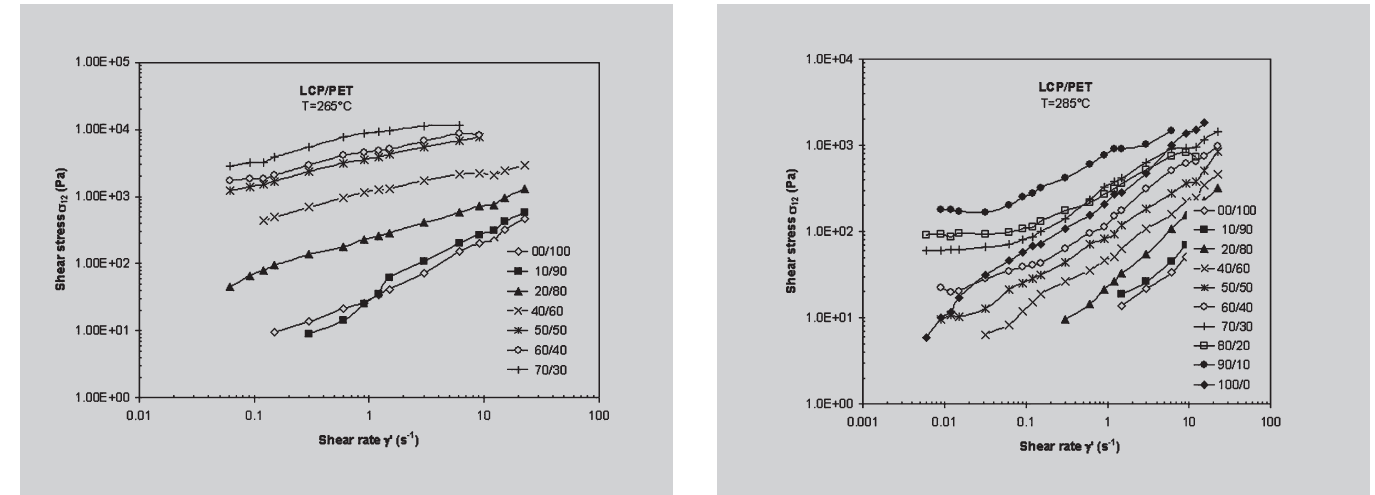
Figure 5 (left): Plots between shear stress and shear rate at 265°C for LCP/PET blends. Figure 6: Plots between shear stress and shear rate at 285°C for LCP/PET